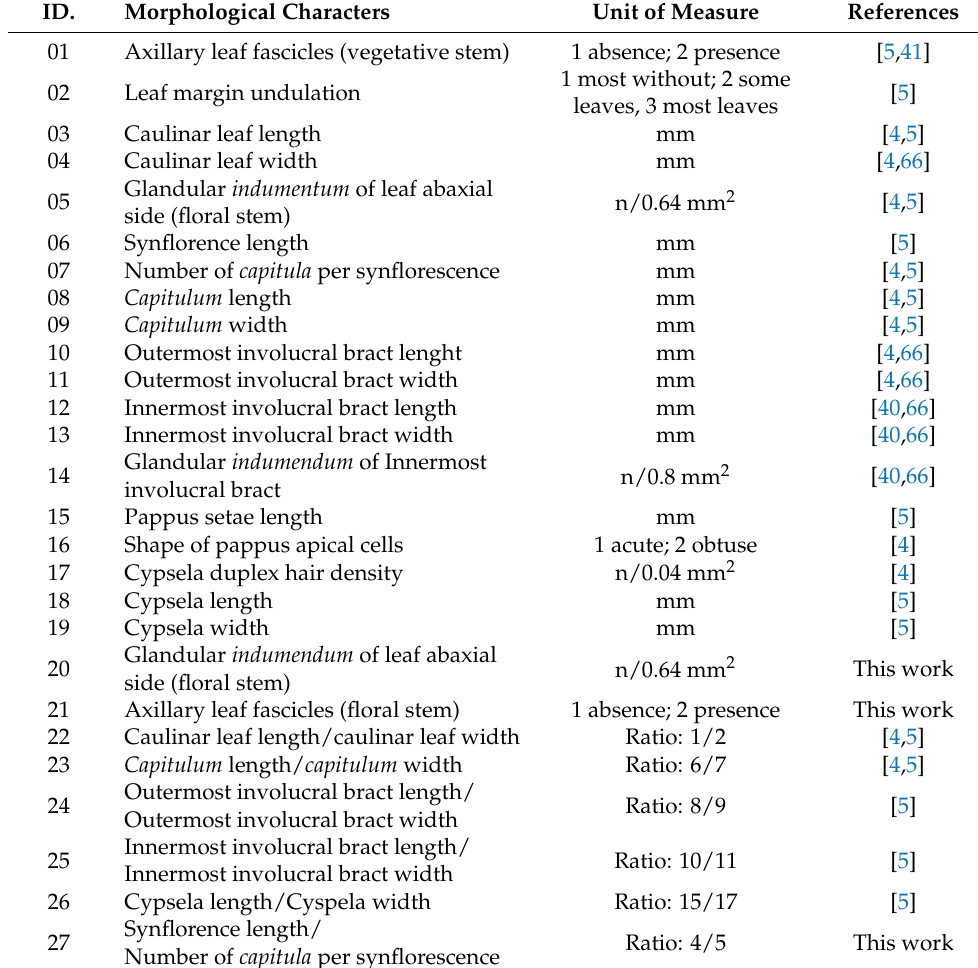
Table 2. List of morphological characters used in the morphometric analysis, with the indication of the unit of measure and the references.